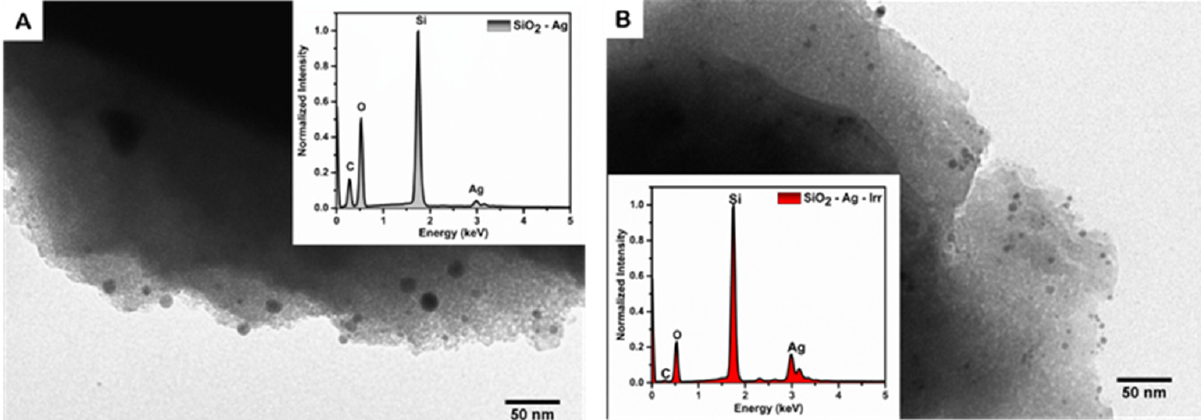
Figure 2. TEM images of SiO 2 -Ag ( A ) and SiO 2 -Ag-Irr ( B ). Insertion: EDX spectra of: ( A ) SiO 2 -Ag; ( B ) SiO 2 -Ag-Irr.